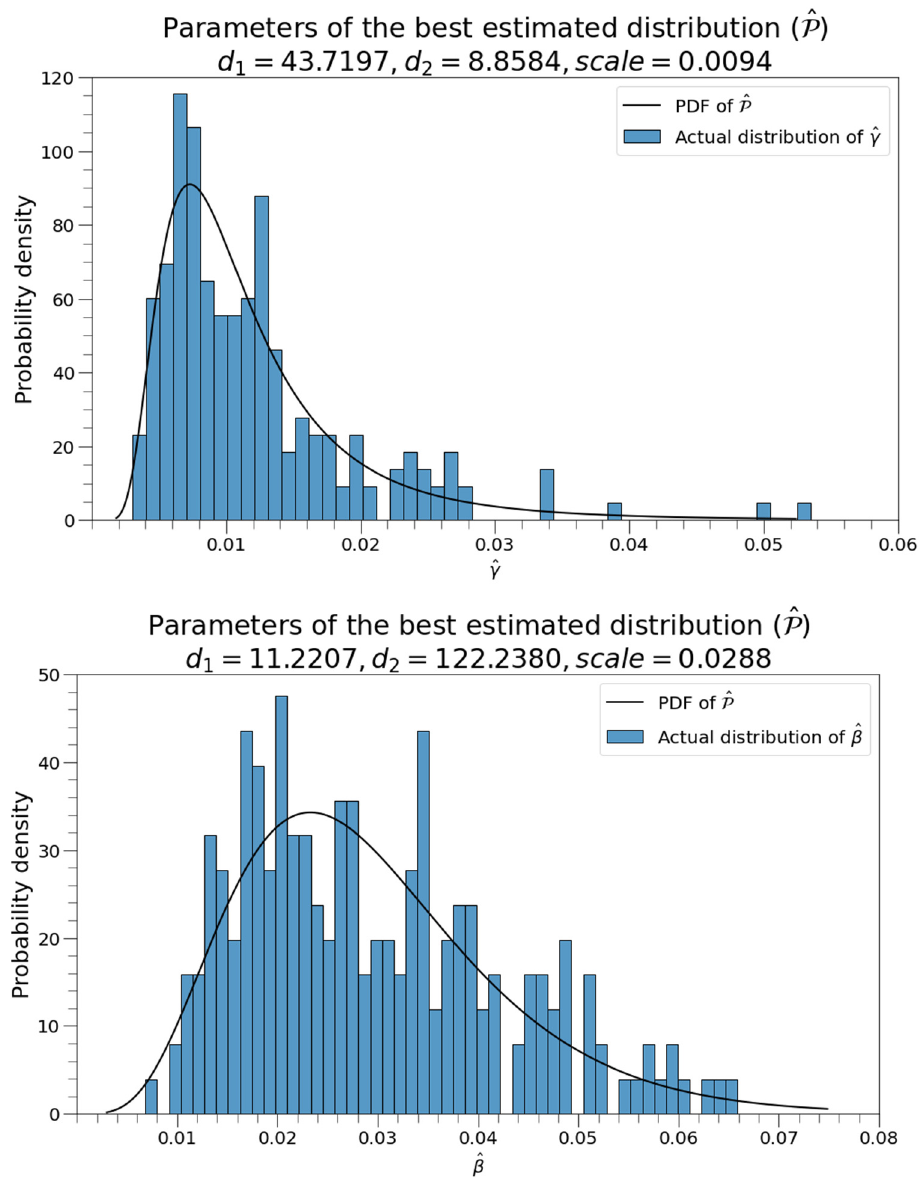
Figure 4. Best estimated distribution of ˆ γ and ˆ β